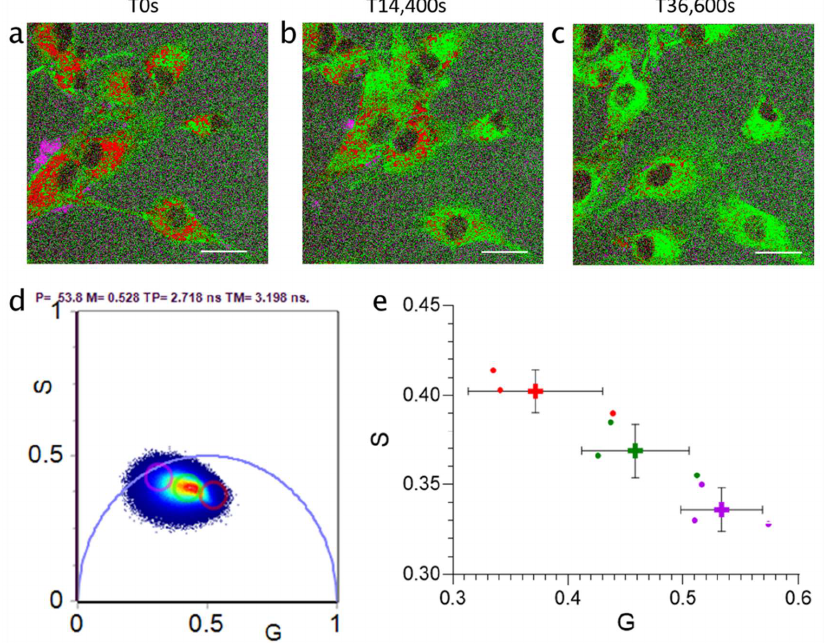
Figure 1. Comparison of photon counts using RapidFLIM versus the attenuation necessary for FLIM detector dead time recovery. ( a ) Attenuated (FLIM) greyscale image of U87 glioblastoma cells following silica nanoparticle (SiNP, 30 nm) addition after 12 h ( b ) Attenuated (FLIM) representative photon counts per pixel over 25 ns, the repetition rate of the laser. ( c ) RapidFLIM greyscale image of U87 glioblastoma cells following silica nanoparticle (SiNP, 30 nm) addition after 12 h, using the same field of view with ( d ) representative photon counts per pixel over 25 ns. ( e ) Overall decays across each frame of attenuated (FLIM, blue line) compared to RapidFLIM acquisition over time. Scale bars, 20 µ m.